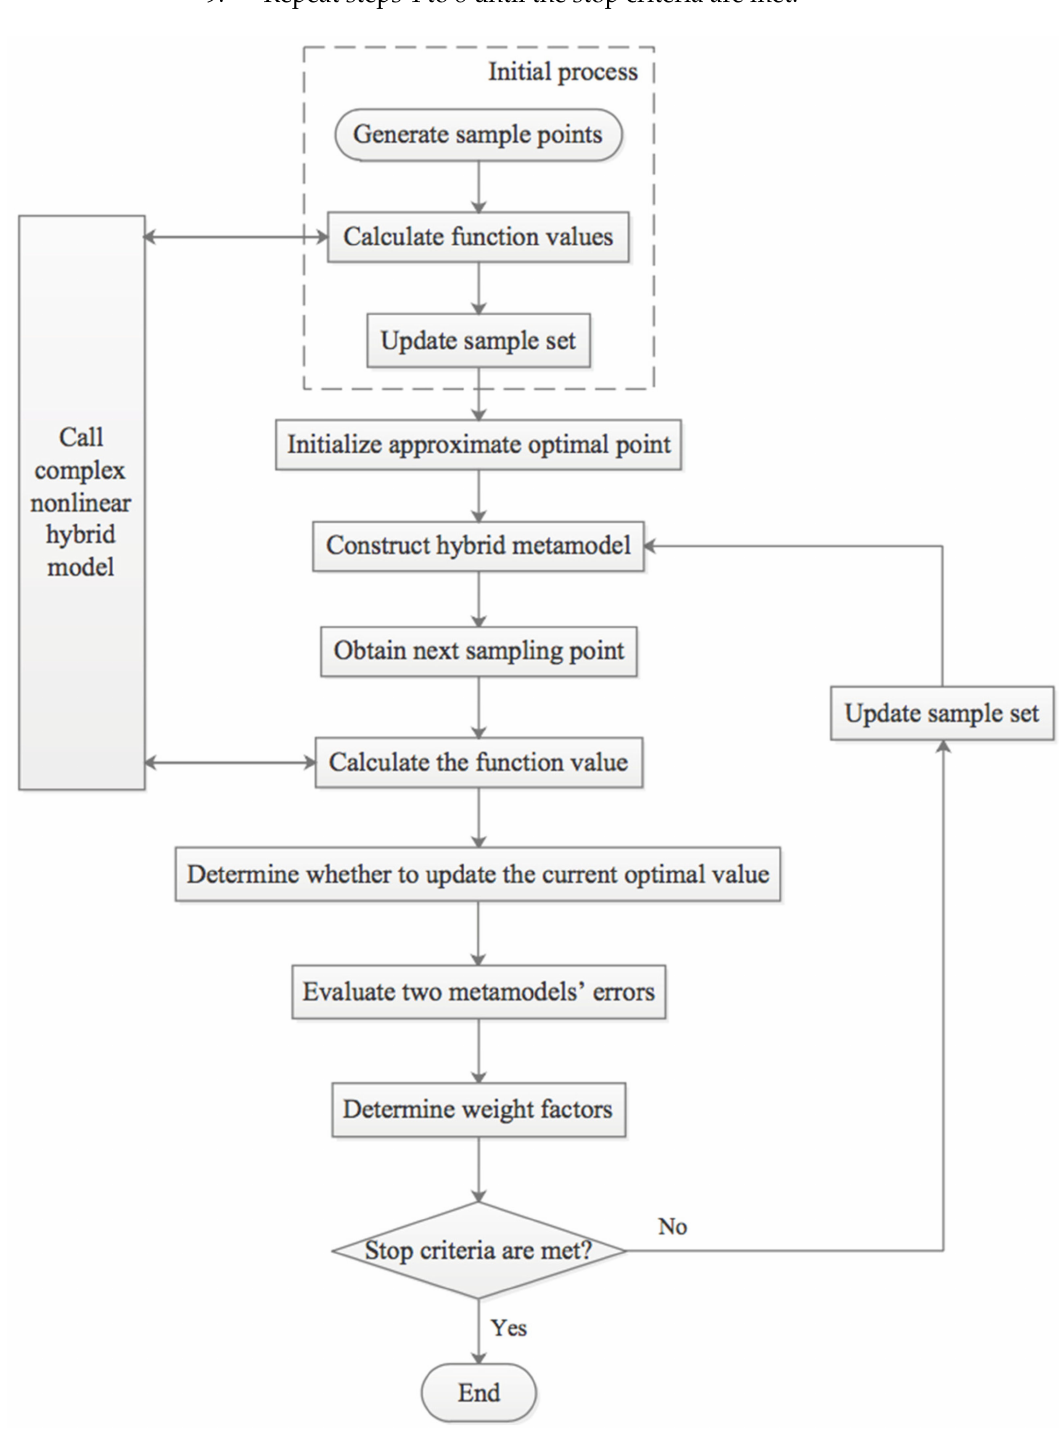
Figure 23. Flow chart of